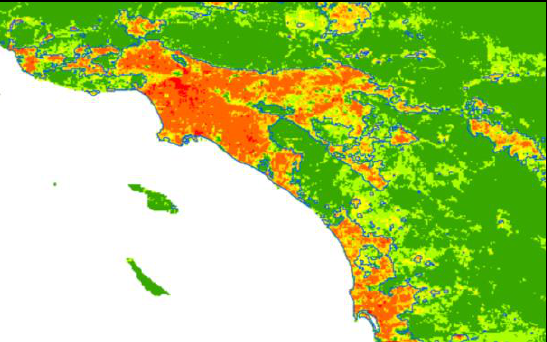
Figure 7. Overlap between Highly Impacted Areas (164 contours) with LandScan in Southern California The overlapping allows typifying world urban areas based on their population size. The paper differentiates metropolitan areas (with a population > 1,000,000 inhabitants), medium cities (from 100,000 to 1,000,000 inhabitants), small cities (10,000-100,000 inhabitants), villages (between 1,000 and 10,000 inhabitants), and other types of urban settlements (< 1,000 inhabitants).